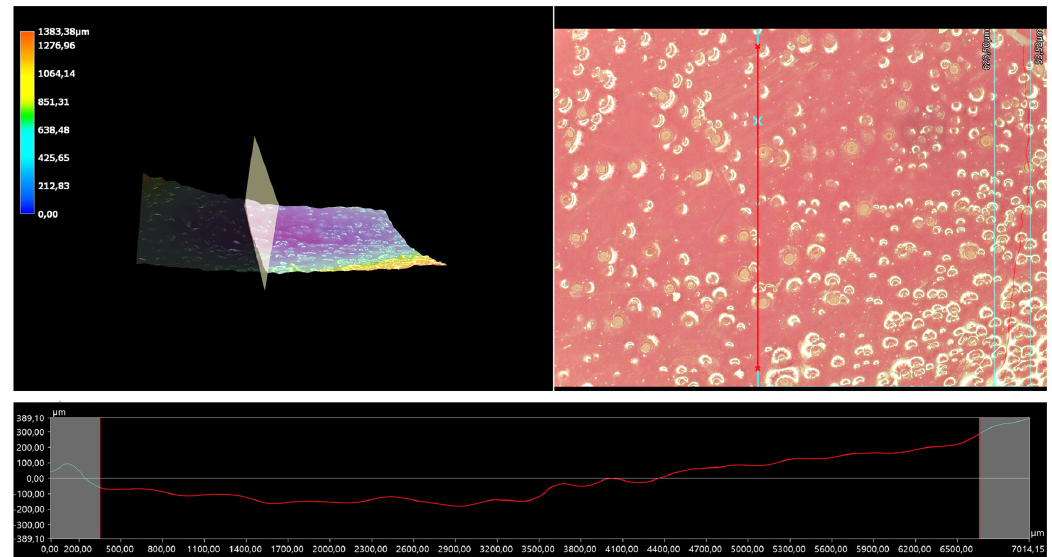
Figure 11. A 3D view of the roughness profile of sample